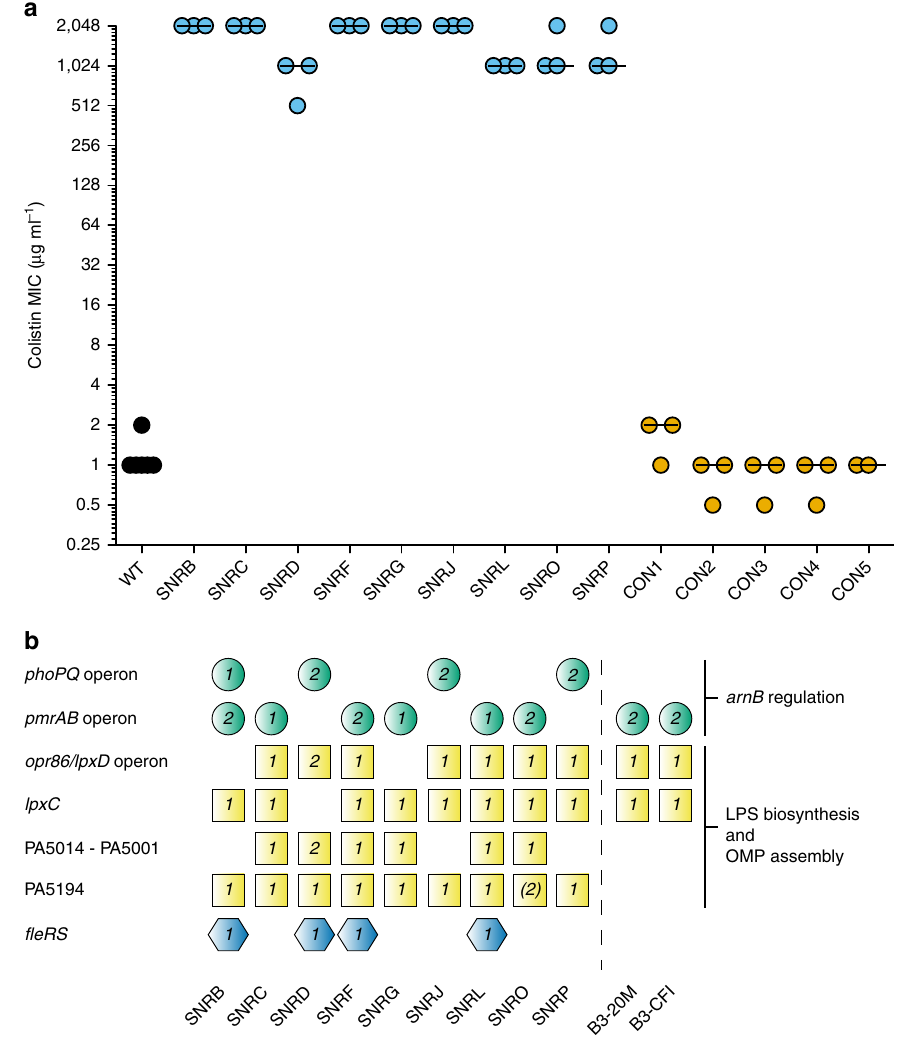
Figure 2 | Experimental evolution of high-level colistin resistance in P. aeruginosa . ( a ) Colistin MIC values ( m gml (cid:2) 1 ) for Wildtype (WT) ancestral P. aeruginosa PAO1; SNRB through SNRP are colistin-resistant clones from surviving selection lineages. CON1 through CON5 are clones from control lineages grown in LB medium in the absence of colistin. CON1 is a mutator strain with mutation in mutS . Colistin MIC was determined by microbroth dilution assays. Horizontal lines indicate the median and symbols indicate biological replicates for MIC determination (at least three replicates were used per strain except for CON5). ( b ) Parallel evolution of colistin resistance in vitro . Shown are operons or genes with mutations in more than three colistin-resistant strains. The symbols contain the number of mutations at the locus. Strain SNRO did not have a mutation in ORF PA5194 but had a mutation immediately upstream and a mutation downstream of the gene. Circles, genes affecting arnB -operon regulation; squares, genes affecting LPS biosynthesis or outer membrane assembly; hexagons, genes affecting other functions; dotted line, in vitro selected strains and clinical